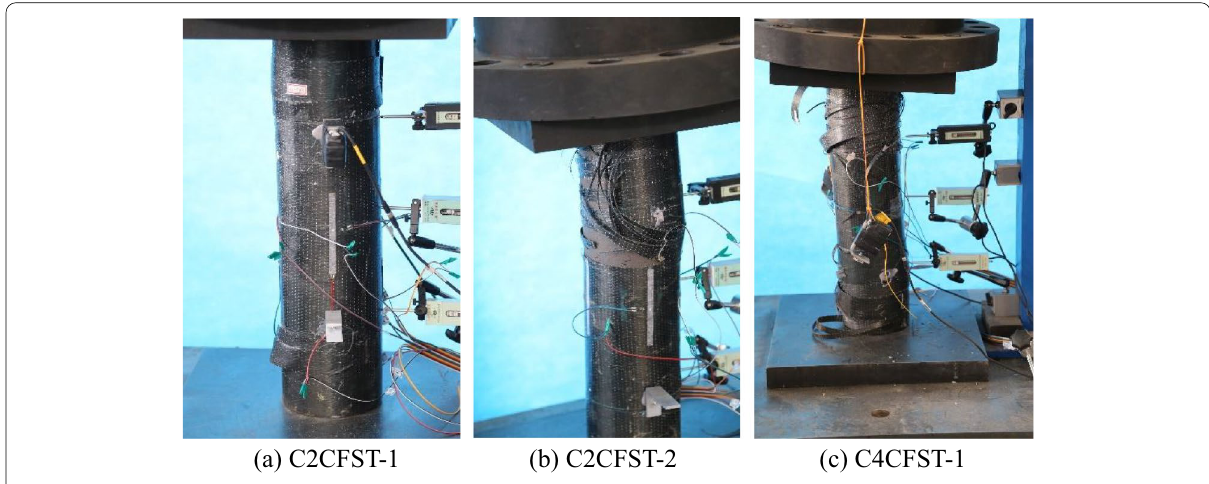
Fig. 9 Failure mode of FRP-strengthened CFST